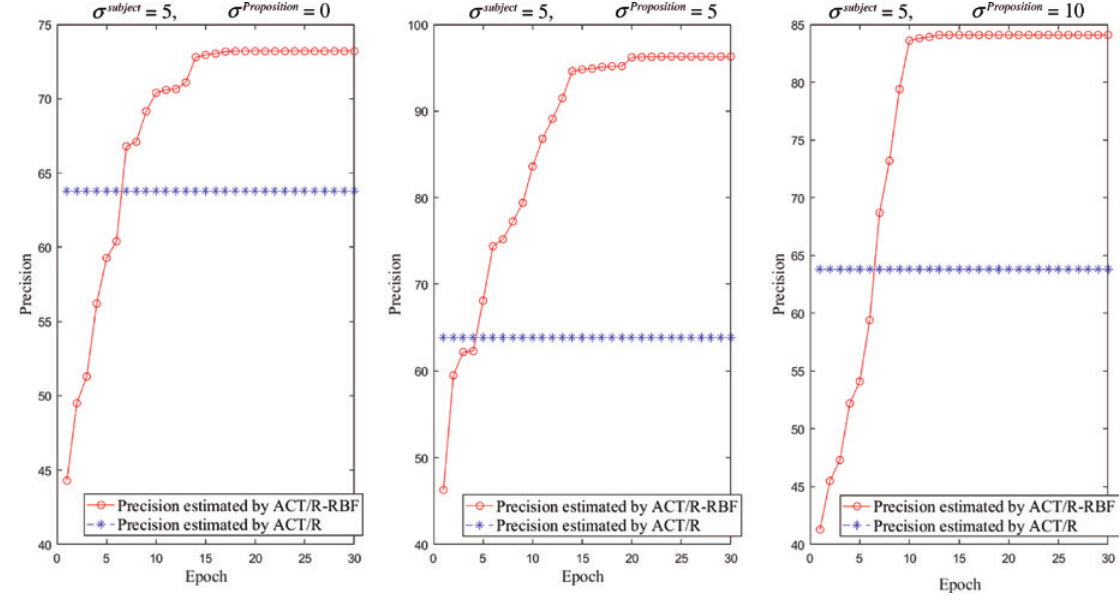
Figure 6: Comparison of the Precision of ACT/R and Hybrid ACT/R-RBF Decision-Making Model for σ Subject =